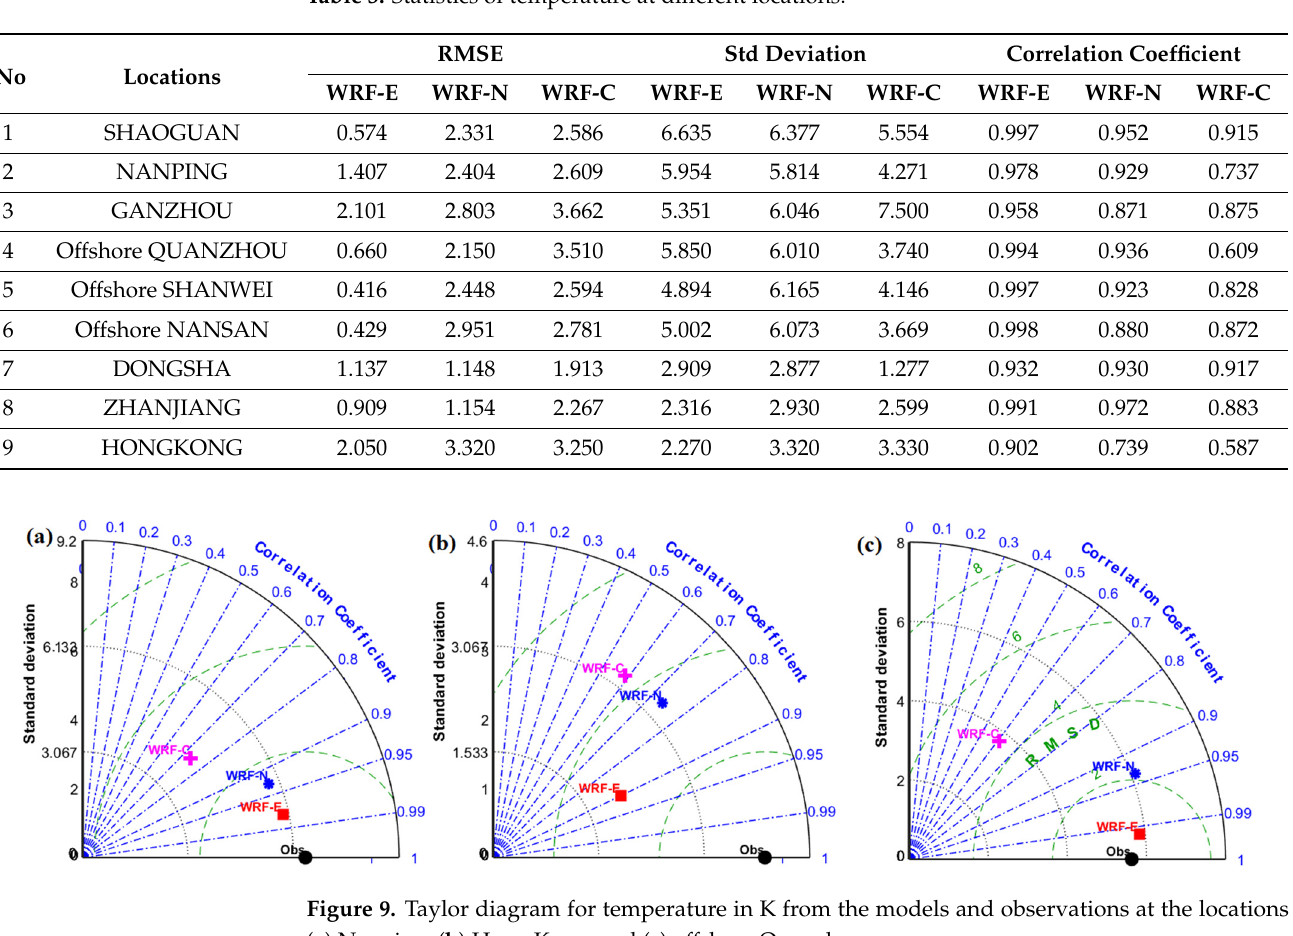
Figure 9. Taylor diagram for temperature in K from the models and observations at the locations ( a ) Nanping, ( b ) Hong Kong, and ( c ) offshore Quanzhou.